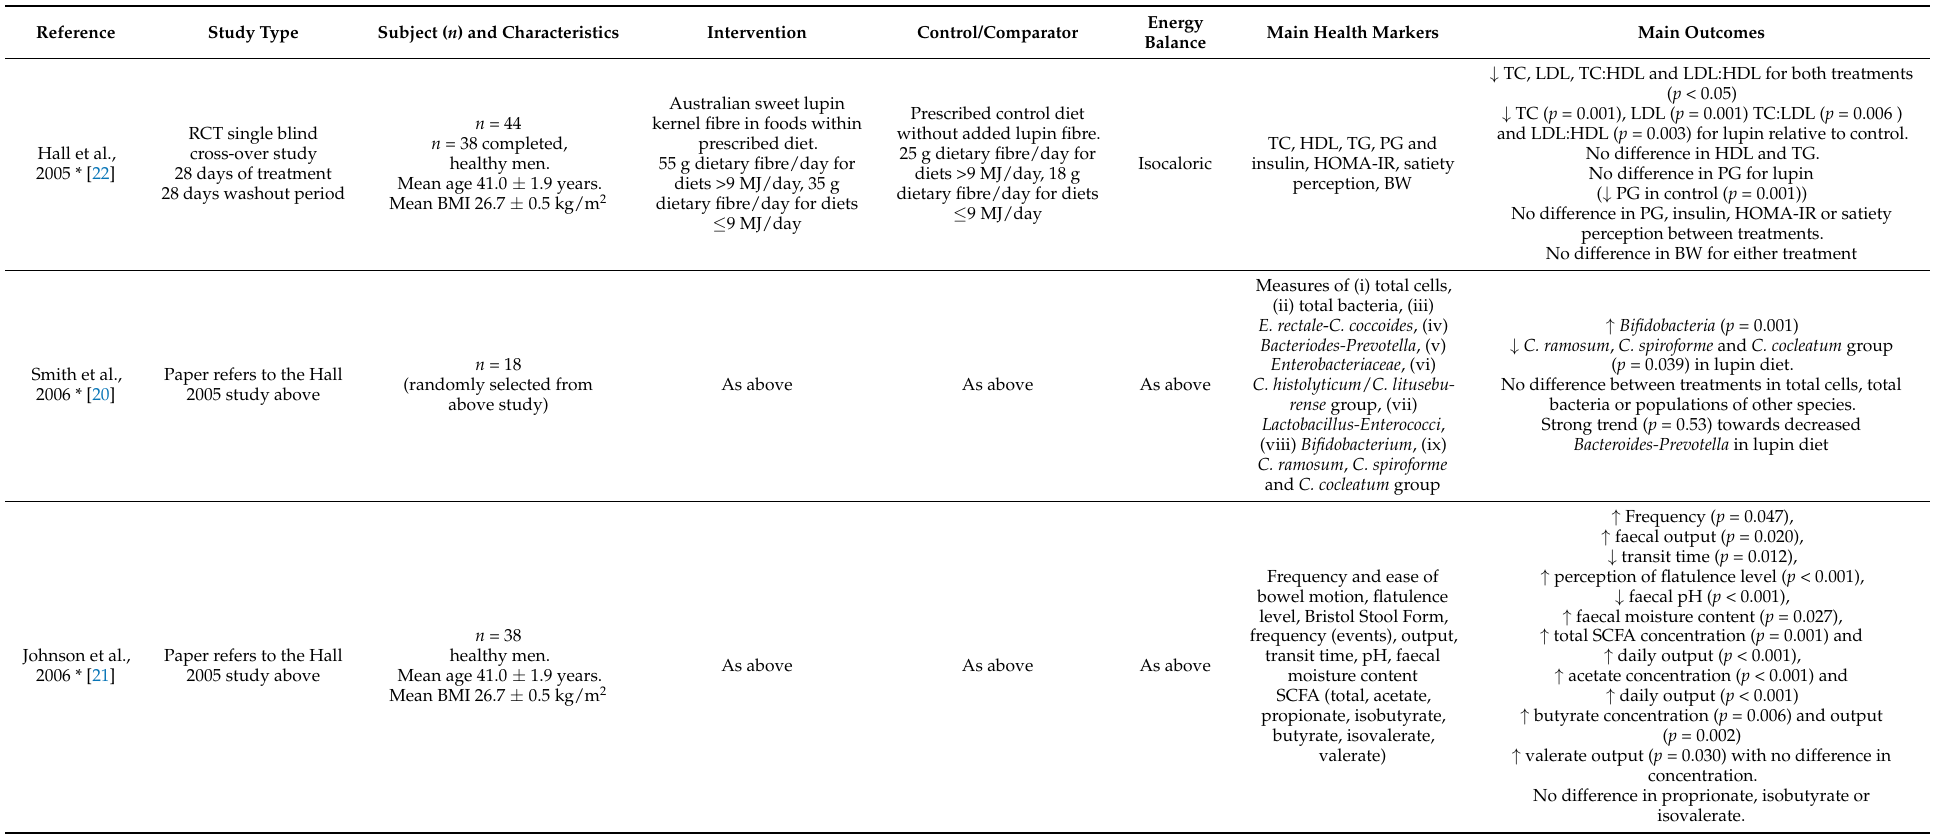
Table 4. Characteristics and major outcomes of studies examining lupin fibre consumption and health